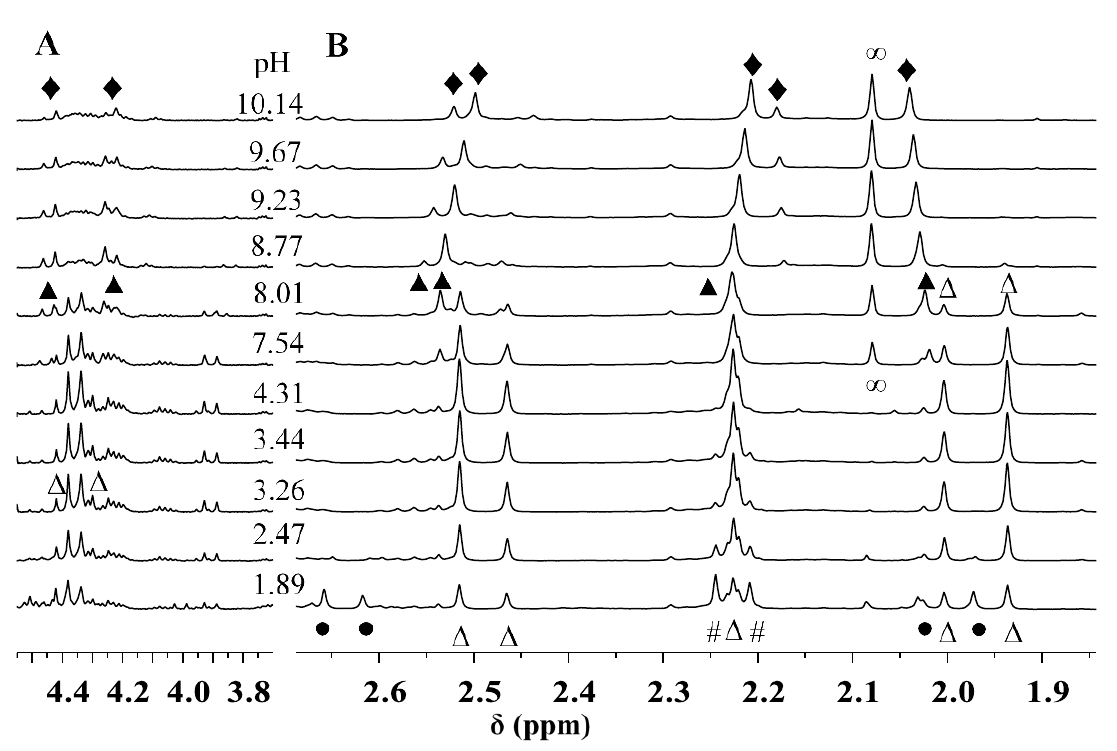
Figure 13. pH-dependence of the NMR signals detected in the [( η 6 - p -cym)Ru] 2+ –L5 system at 2.2:1 metal-ion-to-ligand-ratio, c L5 = 5.0 mM, t = 48 h. Symbols represent the signals belonging to the following species: [M(H 2 O) 3 ] 2+ and [M(Cl) 3 ] – (#), [MH 2 L] 3+ (•), [M 2 L] 3+ (Δ), [M 2 H –1 L ] 2+ ( ▲ ),[M 2 H –2 L ] + ( ♦ ) [M 2 (OH) 3 ] + (∞). The intensity scales are different for ( A ) and ( B ) for clarity.